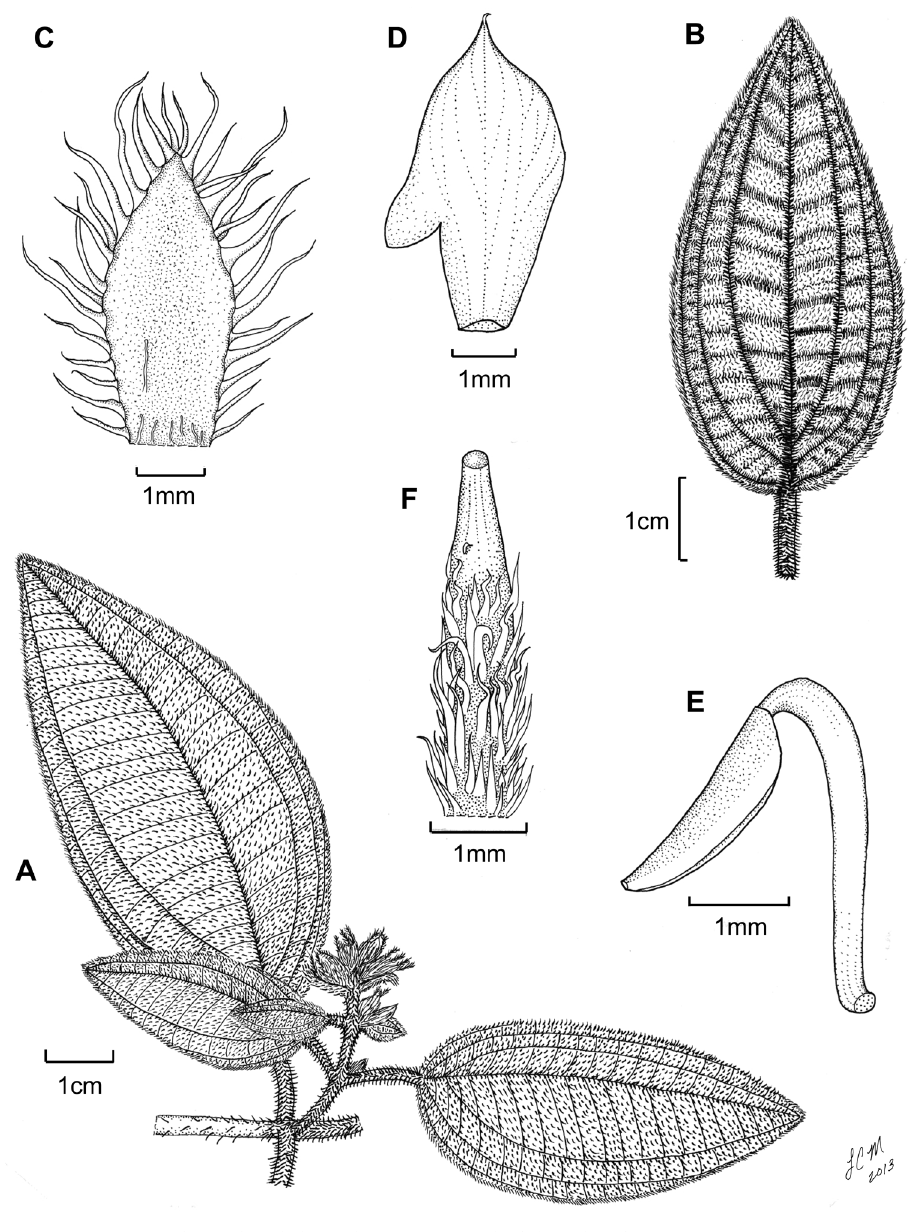
Figure 5. Miconia hirtistyla A habit ( Ekman 14617 ) B leaf abaxial surface ( León LS-10923 ) C bracteole ( León LS-10923 ) D petal ( Ekman 14617 ) E stamen ( Ekman 14617 ) F style ( Ekman 14617 ). Reproduced with permission from Majure et al.